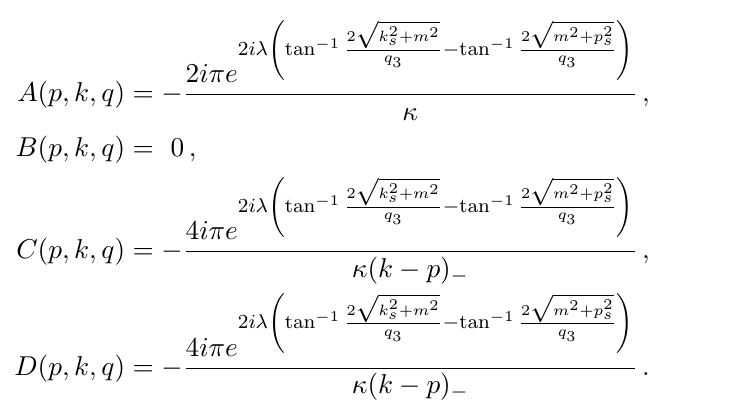
Figure 4 . The Dyson-Schwinger series for the o(cid:11)-shell four-point function in the charged sector. The blob represents the o(cid:11)-shell four-point function to all orders in the ’t Hooft coupling (cid:21) . Note that these equations are the same as the equations 3.32{3.35 of [27] for the N = 2 theory. 17 It follows then that the solutions of the unknown functions for the charged sector are the same as that for the N = 2 theory. We found that the integral equations (5.28) are solved in the kinematic regime q = 0 (cid:6)